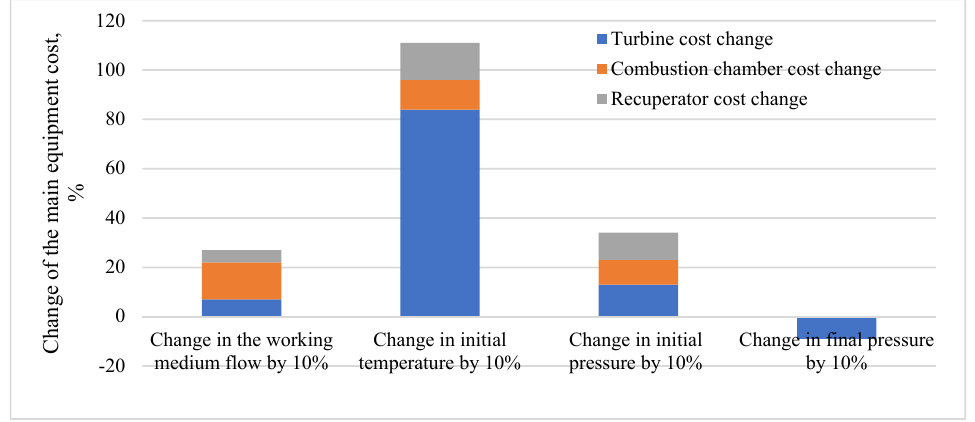
Figure 12. Influence of key thermodynamic parameters on the oxy-fuel facility equipment price.